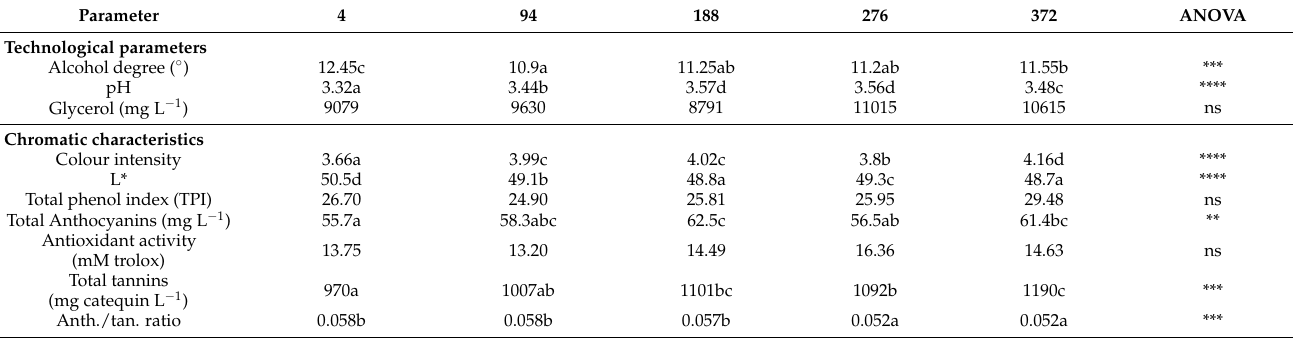
Table 12. Average values of chemical parameters, chromatic characteristics, and phenolic and aminoacidic composition of wines at the end of the malolactic fermentation for clones 372, 276, 188, 94, and 4 (under control conditions) in